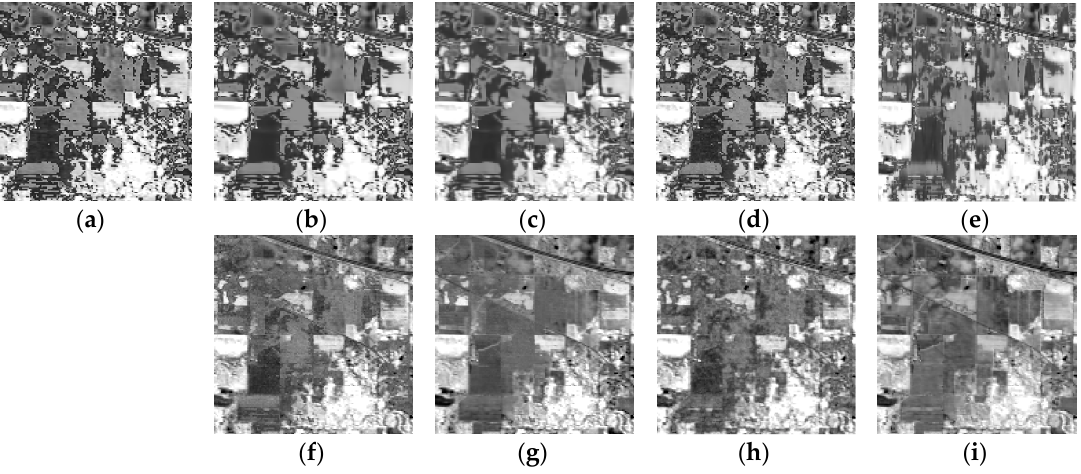
Figure 8. Denoising results for band 61 of the Indian Pine data: ( a ) Original image; ( b ) BM3D; ( c ) BM4D; ( d ) PCA + BM4D; ( e ) KSVD; ( f ) LRMR; ( g ) NAILRMA; ( h ) BPFA; and ( i ) HyDeSpDLS. Electronics 2019 , 8 , x FOR PEER REVIEW 17 of 19